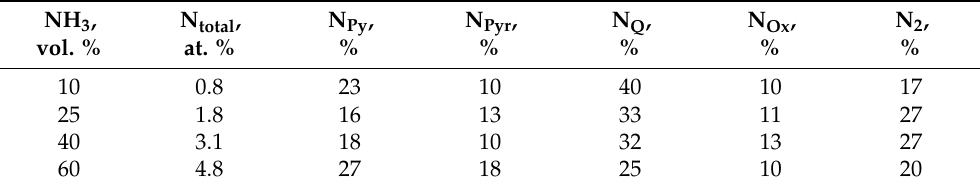
Table 1. Total nitrogen content in N-CNTs and the content of different N-groups. NH 3